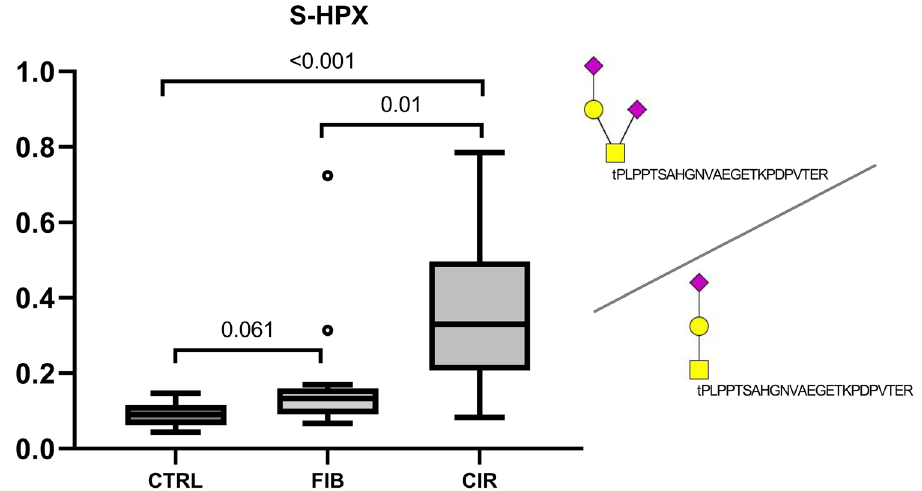
Figure 4. Quantification of S-HPX in the control, fibrosis, and cirrhosis groups (n = 15 each). S-HPX increases significantly in cirrhosis group compared to control ( p < 0.001) and fibrosis (0.01) groups. The yellow rectangle represents HexNAc (GalNAc), yellow circle Hex (Gal), and purple diamond